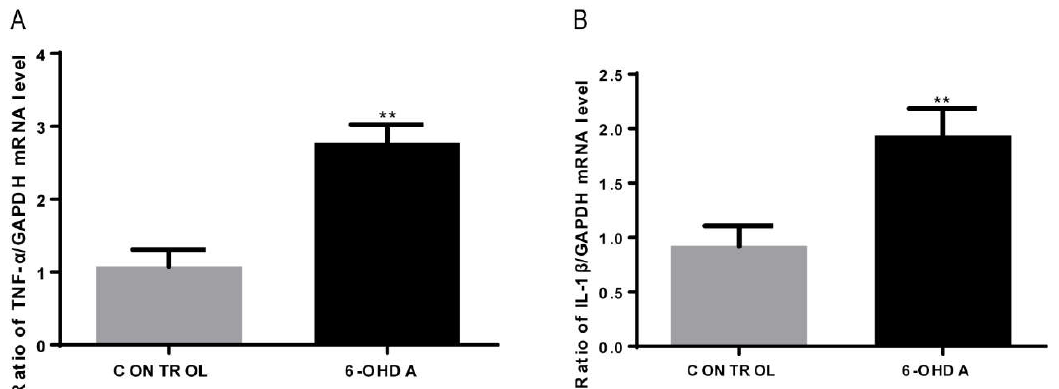
Figure 5. TNF-α and IL-1β mRNA levels in BV2 cells treated with 6-OHDA. ( A ) qRT-PCR assay to measure TNF- α mRNA levels. Data are presented as fold changes in TNF- α mRNA expression in 6-OHDA treatment versus control-treated groups. ( B ) qRT-PCR assay to measure IL-1 β mRNA levels. Data are presented as fold changes in IL-1 β mRNA expressions in 6-OHDA treatment versus control-treated groups. Each bar represents the mean ± SEM from four independent experiments. n = 4. ** p < 0.01, compared with the controls.